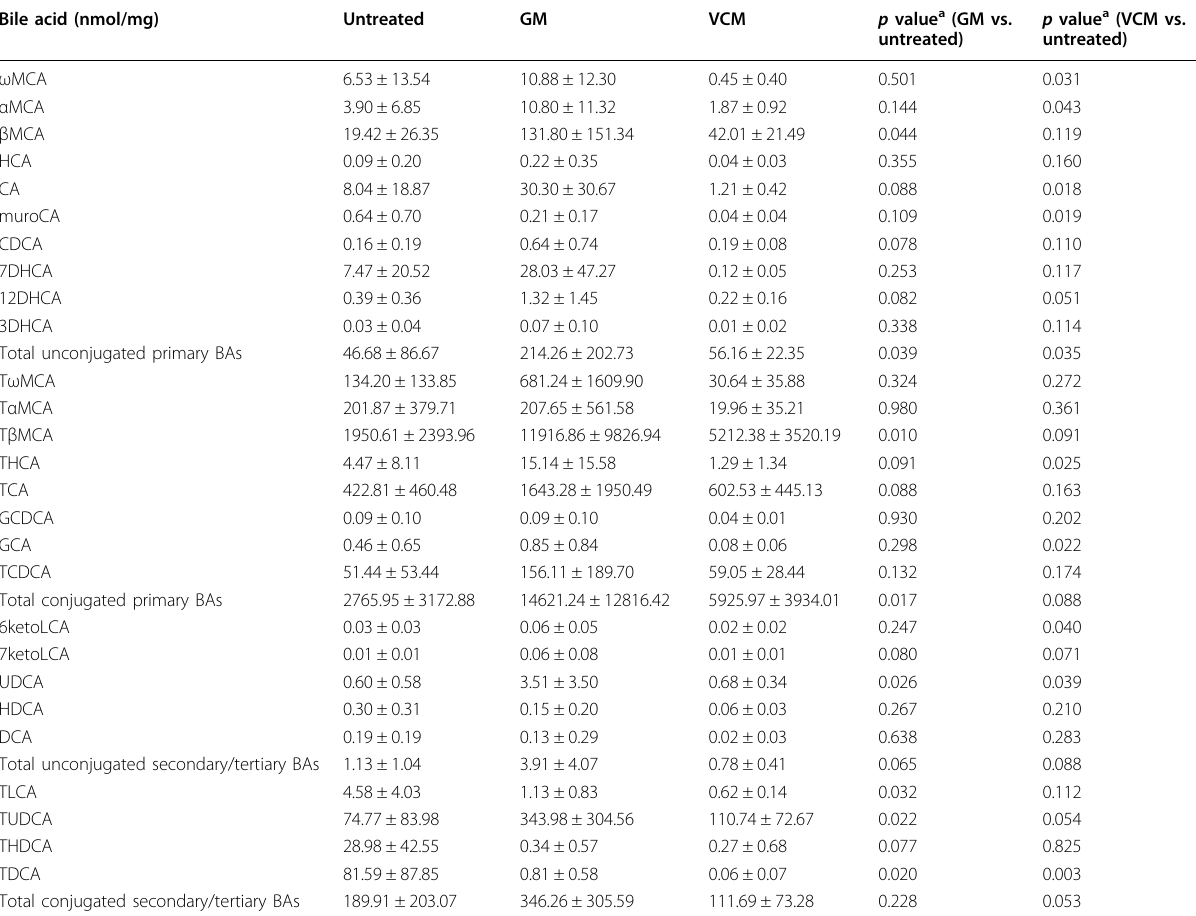
Table 4 Bile acid pro fi les in the liver of mice (nmol/mg protein) Bile acid (nmol/mg) Untreated p value a (GM vs.